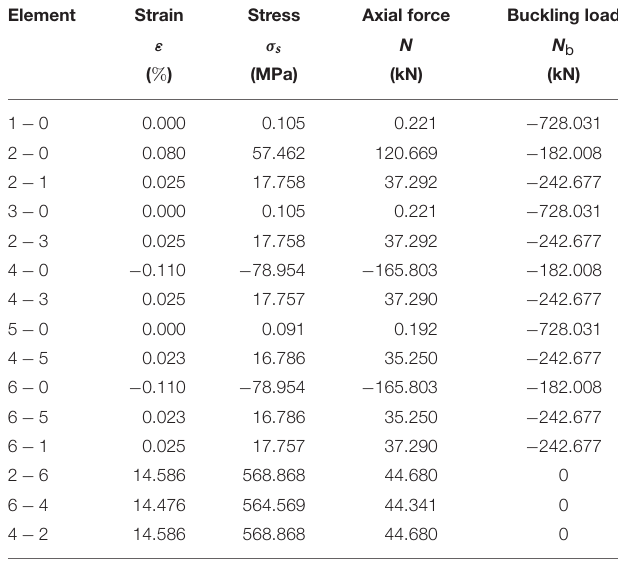
TABLE 5 | Strains, stresses and axial forces produced by the application of positive wind pressure forces on the TABS configuration corresponding to U 0.95 U . =